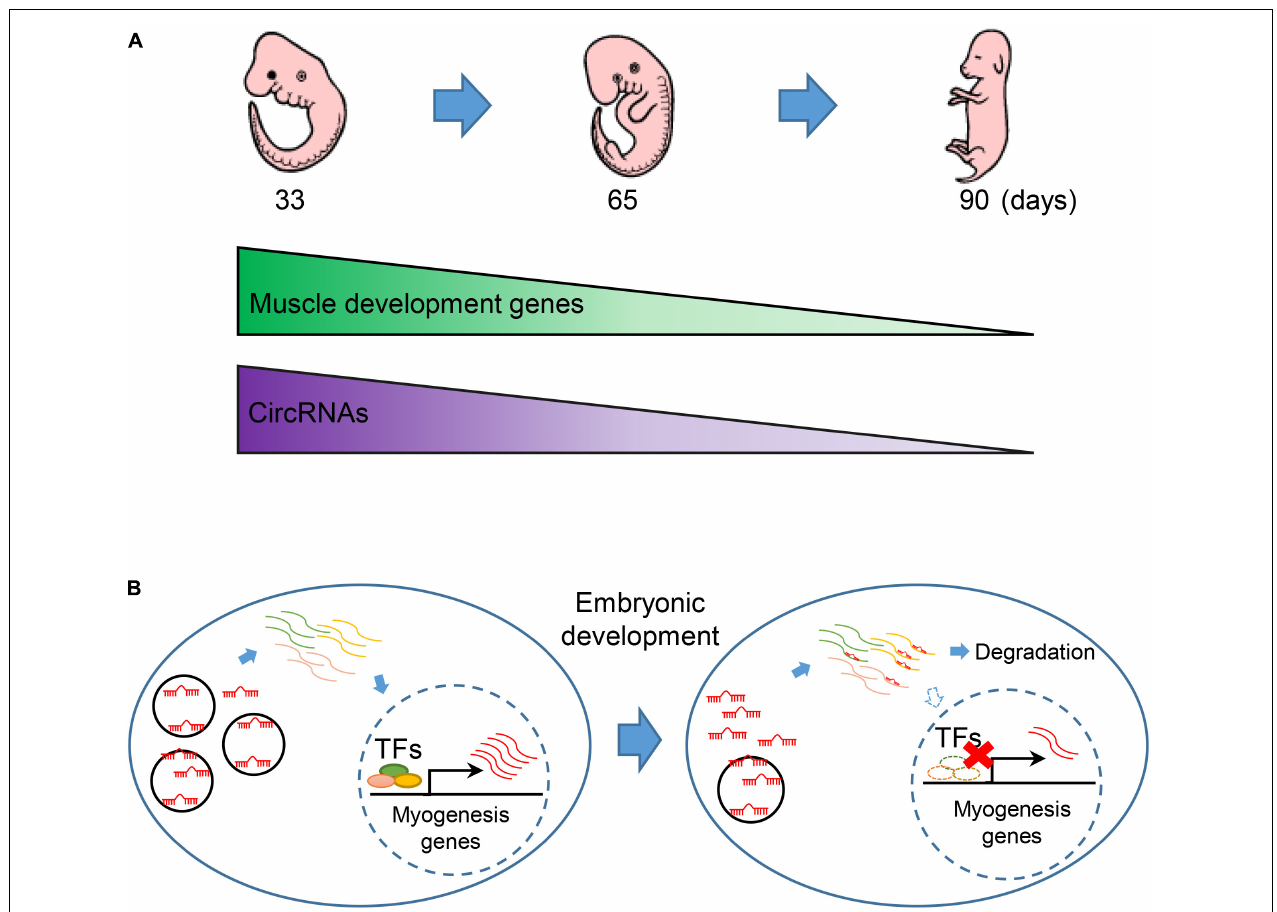
FIGURE 6 | The regulatory model of circRNA during embryonic muscle development. (A) The expression of muscle development genes and circRNAs are synergistically express in the three key time points during prenatal skeletal muscle development. (B) CircRNAs regulate embryonic development in miRNA sponge manner. Down-regulation of circRNAs thus causes the release of miRNA that regulated the abundance of key transcription factors (TFs) and eventually promotes the expression of muscle genes during embryonic muscle